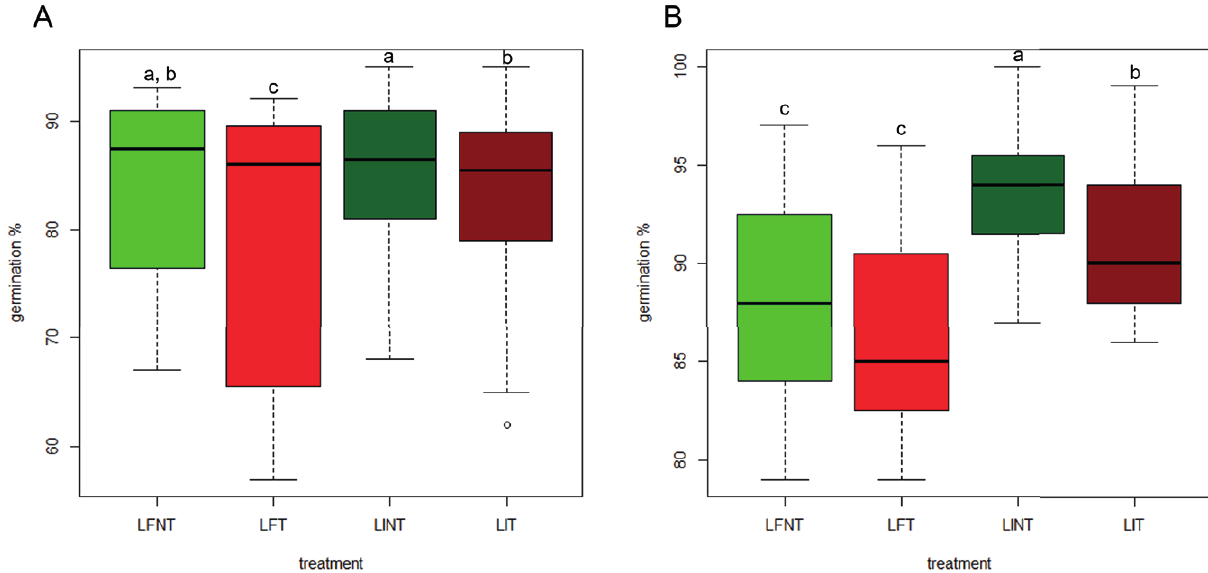
Figure 2. Mean germination rates (%) of Lso-free untreated (LFNT), Lso-free dry treated (LFT), Lso-infected untreated (LINT) and Lso- infected dry treated (LIT) seeds of carrot (A) or parsley (B). In boxplot A, the values are each expressed as mean ± standard deviation for n = 6000 Lso-infected seeds from 15 seed lots, and n = 1200 Lso-free seeds from three lots. In boxplot B, n = 1600 seeds from four seed lots. Diff erent letters accompanying each treatment indicate statistically signifi cant diff erences between treatments (Chi-square post-hoc multiple comparison